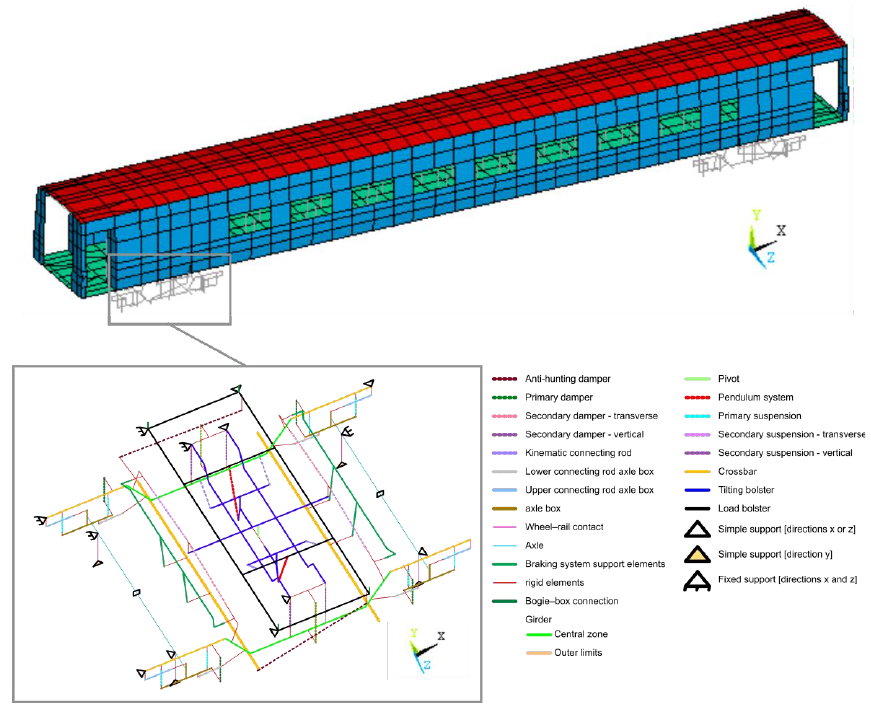
Figure 2. Overview of the BBN vehicle ’s numerical model.